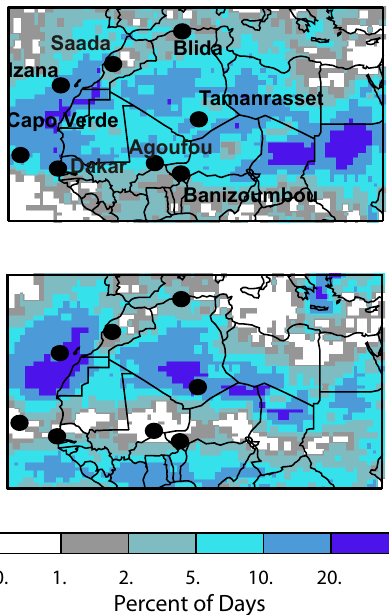
Fig. 6. Percent of days when low level jets occur in the COSMO model results averaged for 2007 and 2008 for the months April to June (top panel) and July to September (bottom panel). The loca- tions of the AERONET stations used for model evaluation are indi- cated on the